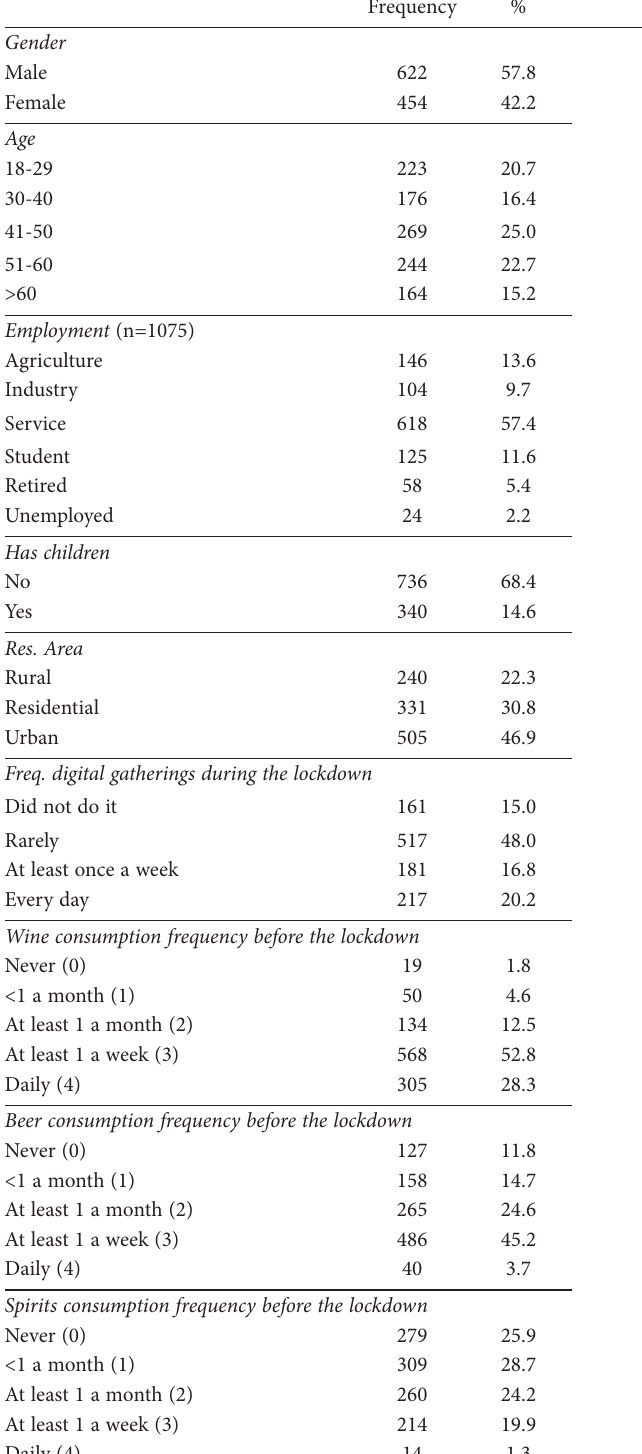
Table 1. Descriptive statistics of the sample.